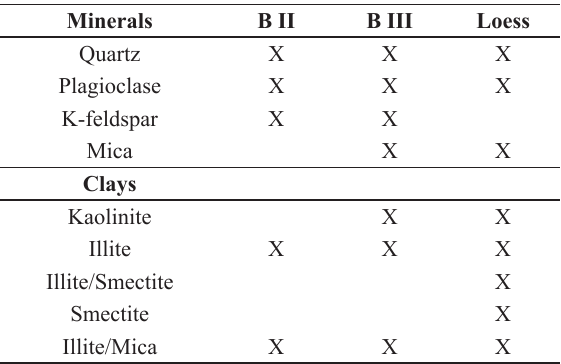
Distribution of the minerals identified by X-ray diffraction in the coarse and clay fractions of the Barriers II and III and in the loess of the Cordão Formation.